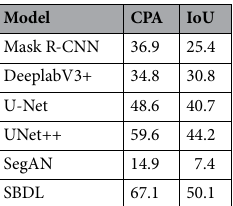
Table 2. Tongue crack segmentation indicators of different models( x ,